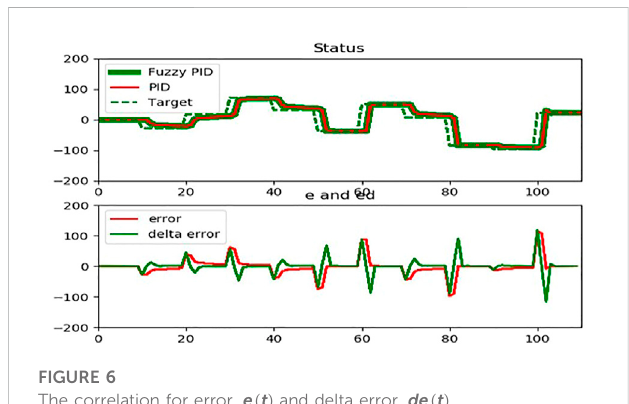
FIGURE 6 The correlation for error, e ( t ) and delta error, de ( t )